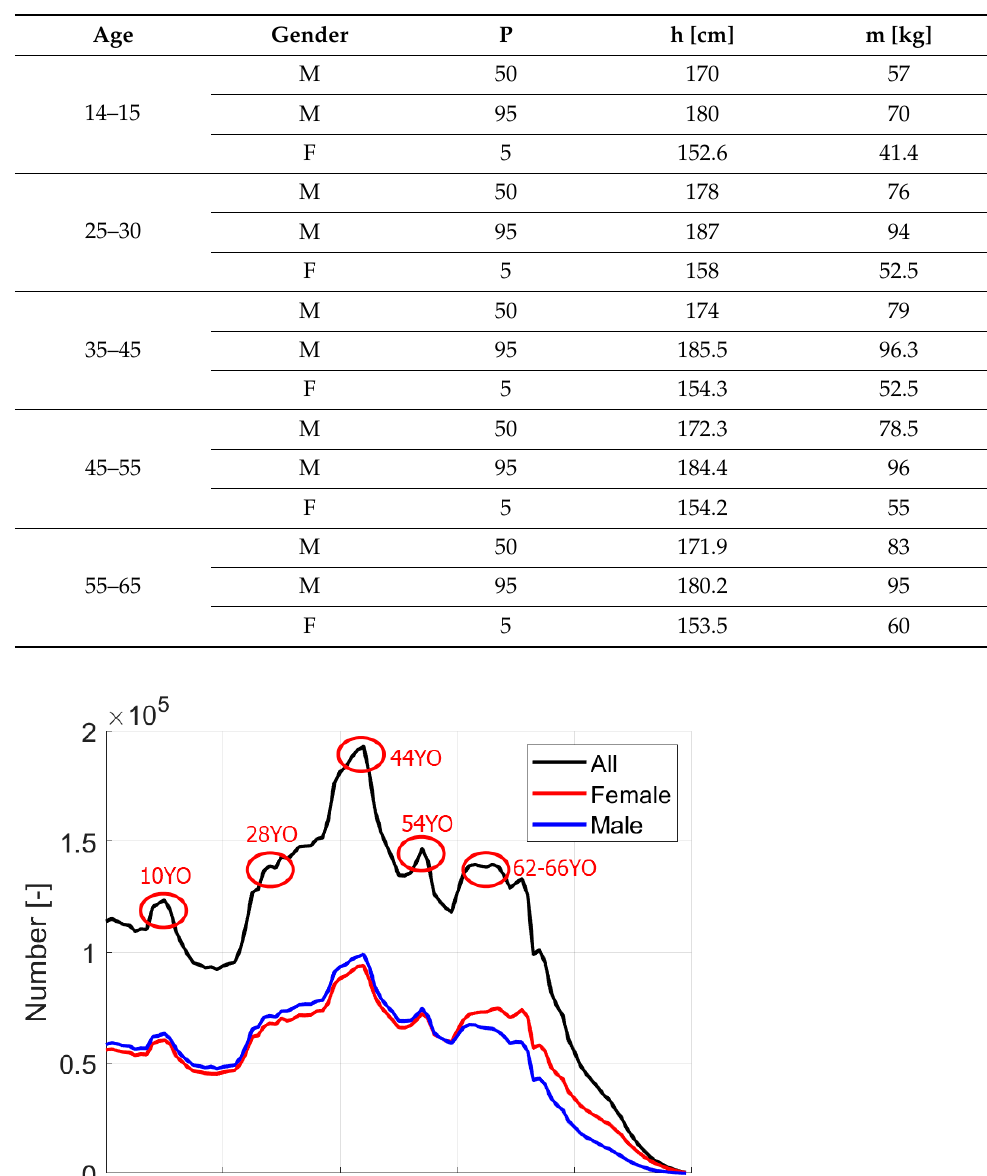
Table 1. Selected occupant anthropometries of Virthuman model.